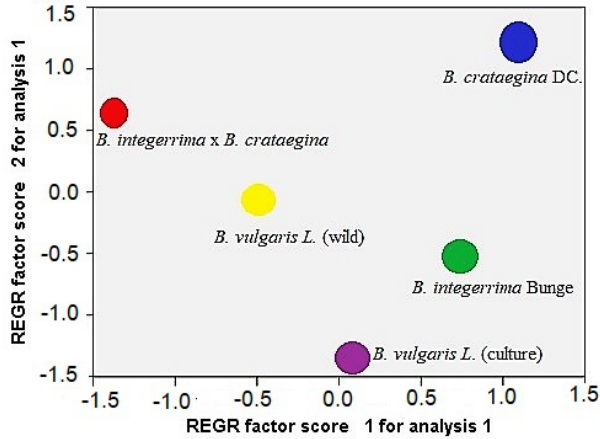
Figure 2. Distribution of the species according to the main components.